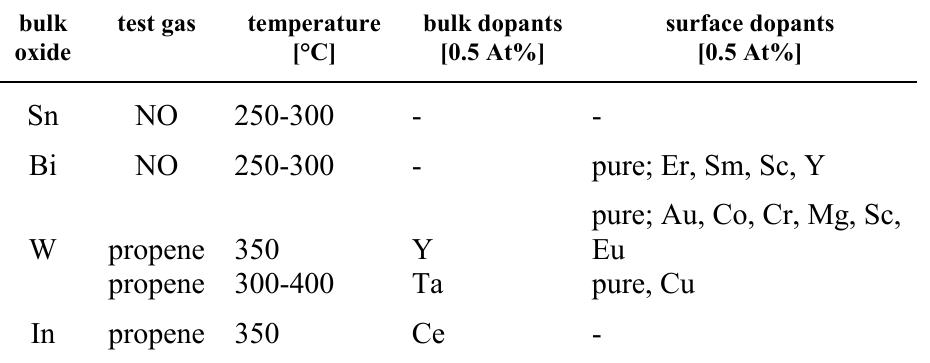
Table 4. Examples of high selective materials extracted from the clusters of fig.